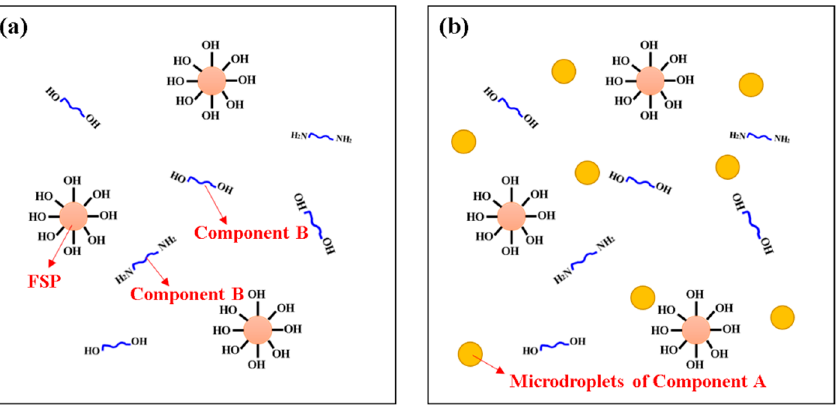
Figure 2. Component B and FSP reaction system ( a ); Component A, B and FSP reaction system ( b ).